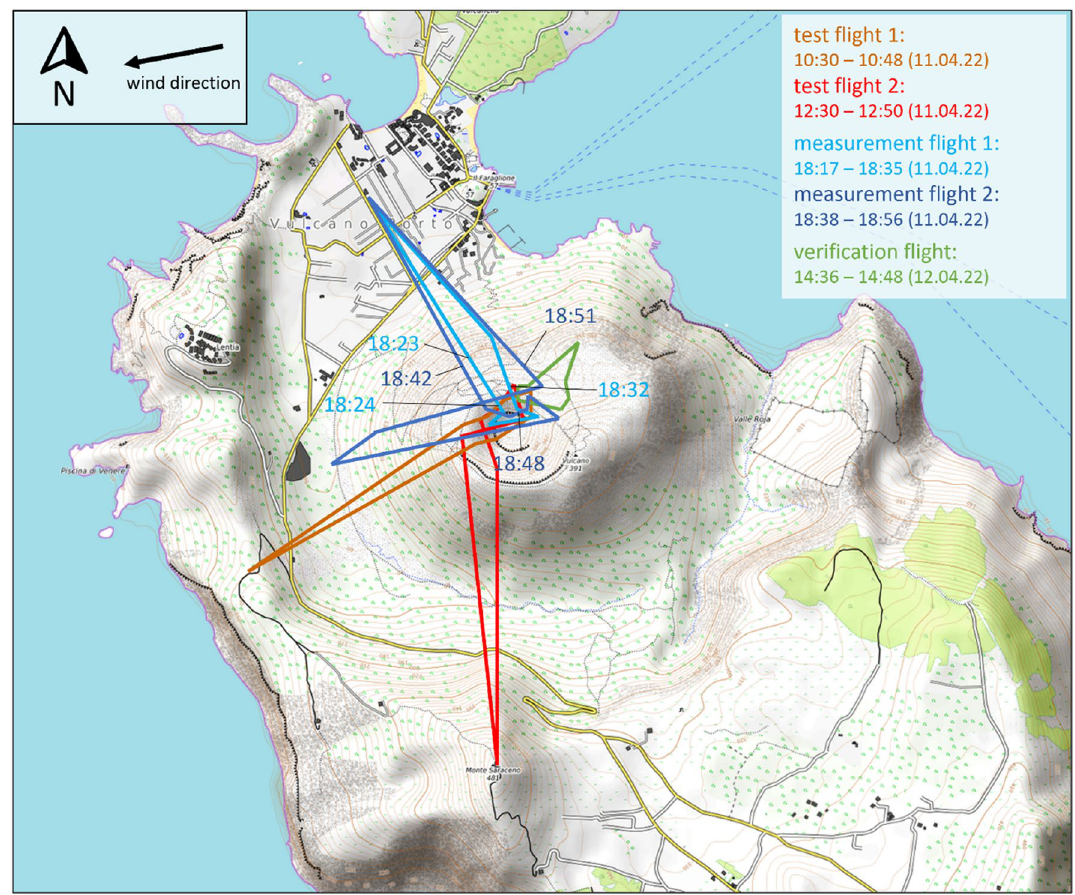
Figure 3. Flight paths of the first two test flights, the two measurement flights and the verification flight. The test flights and the measurement flights were conducted on the 11. April 2022. The verification